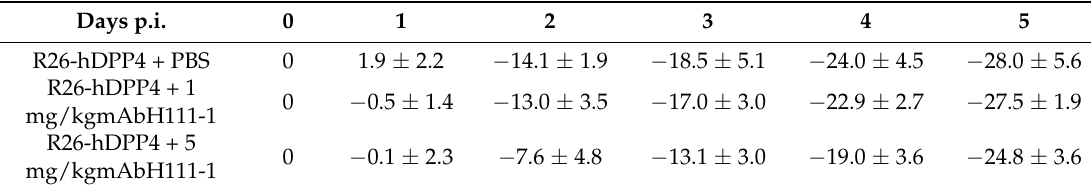
Table 1. Administration of neutralizing mAb H111-1 prevented weight loss in R26-hDPP4 mice infected with MERS-CoV * #